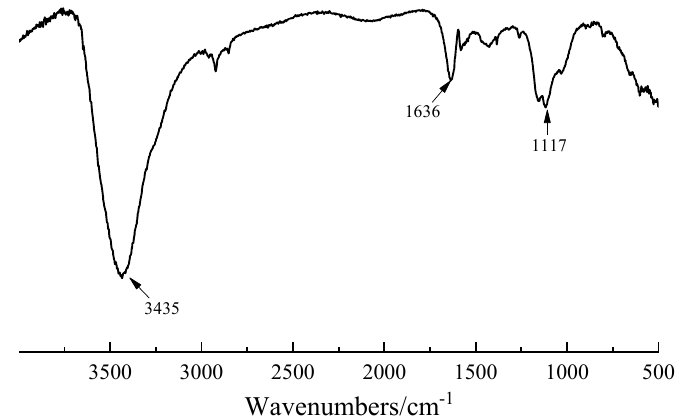
Figure 2. FTIR analysis of GNPs.